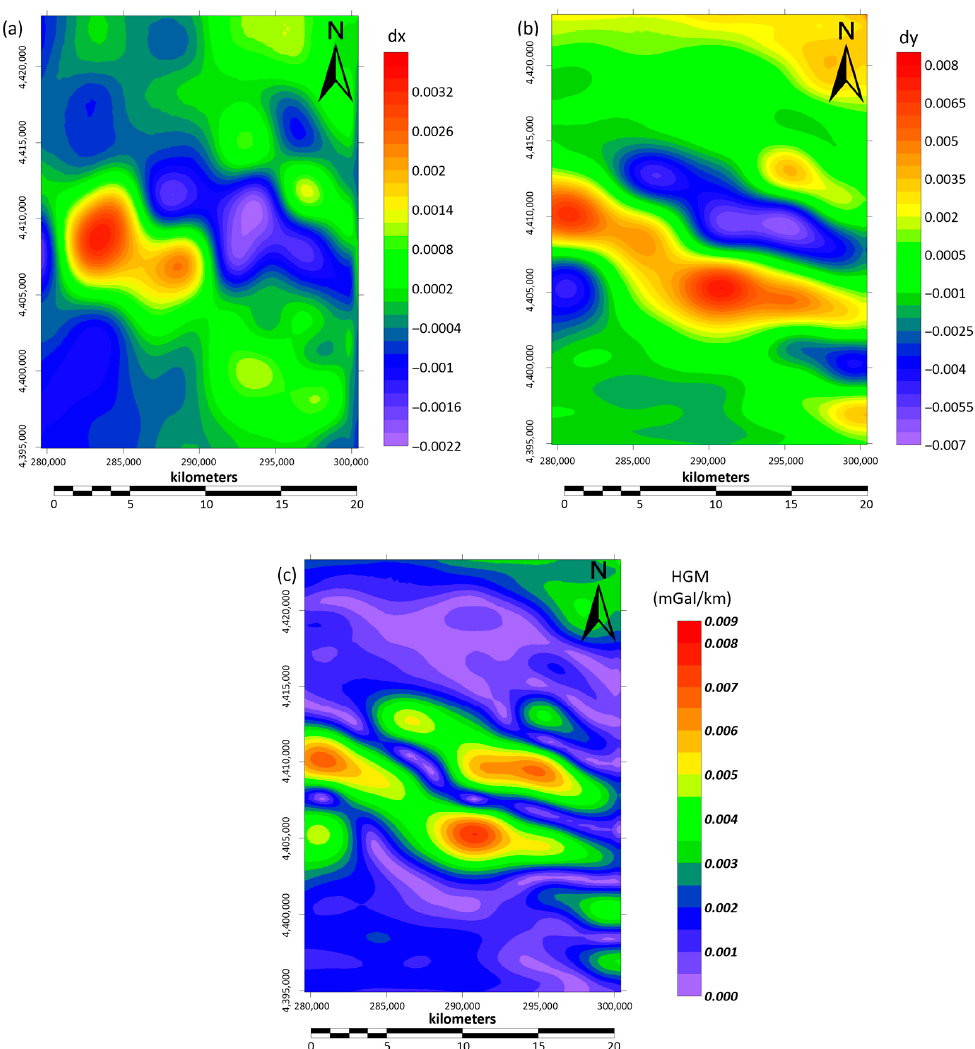
Figure 5. ( a ) X-direction derivative of trend removed gravity data. ( b ) Y-direction derivative of trend removed gravity data. ( c ) Result of the HGM derived from third order trend removed Bouguer anomaly data (datum: WGS84 UTM Zone 36 N).